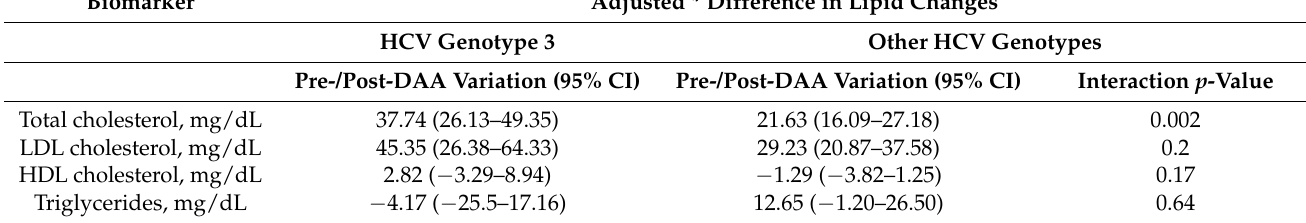
Table 5. Panels A, B, C and D. Estimate of the marginal effect of HCV genotype 3 on lipids using pre-DAA and post-DAA pairs. LDL: low-density lipoprotein cholesterol; and HDL: high-density lipoprotein cholesterol. * Adjusted for time between